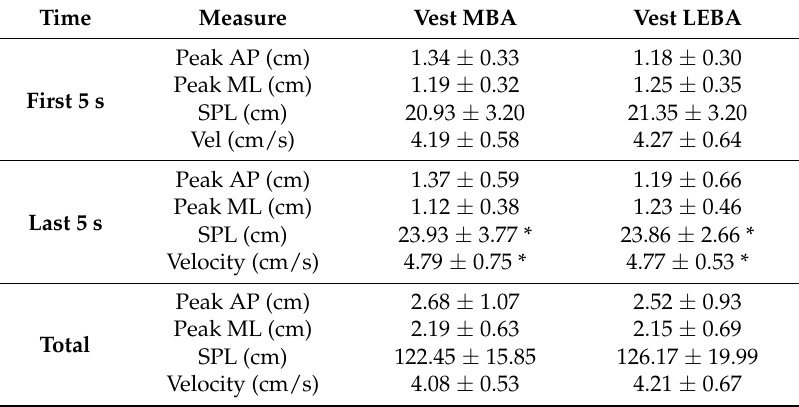
Table 4. Postural sway results (mean ± SD) between the different body armour types.